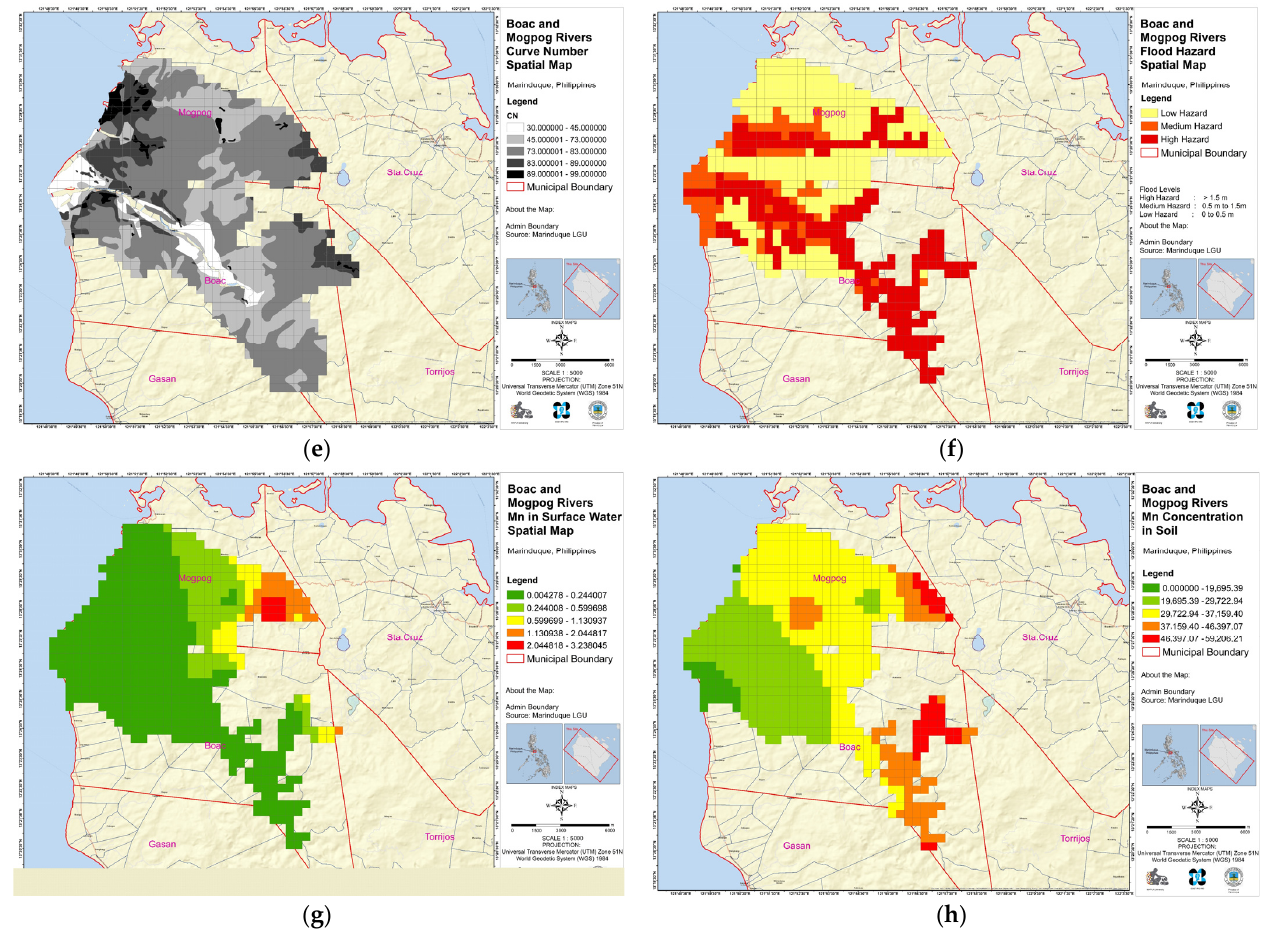
Figure 6. Spatial Grid map of ( a ) pH SW, ( b ) EC SW, ( c ) TDS SW, ( d ) Temperature SW, ( e ) Curve Number, ( f ) Flood hazard map, ( g ) Mn concentration in SW and ( h ) Mn content of soils with a 500 m grid size.